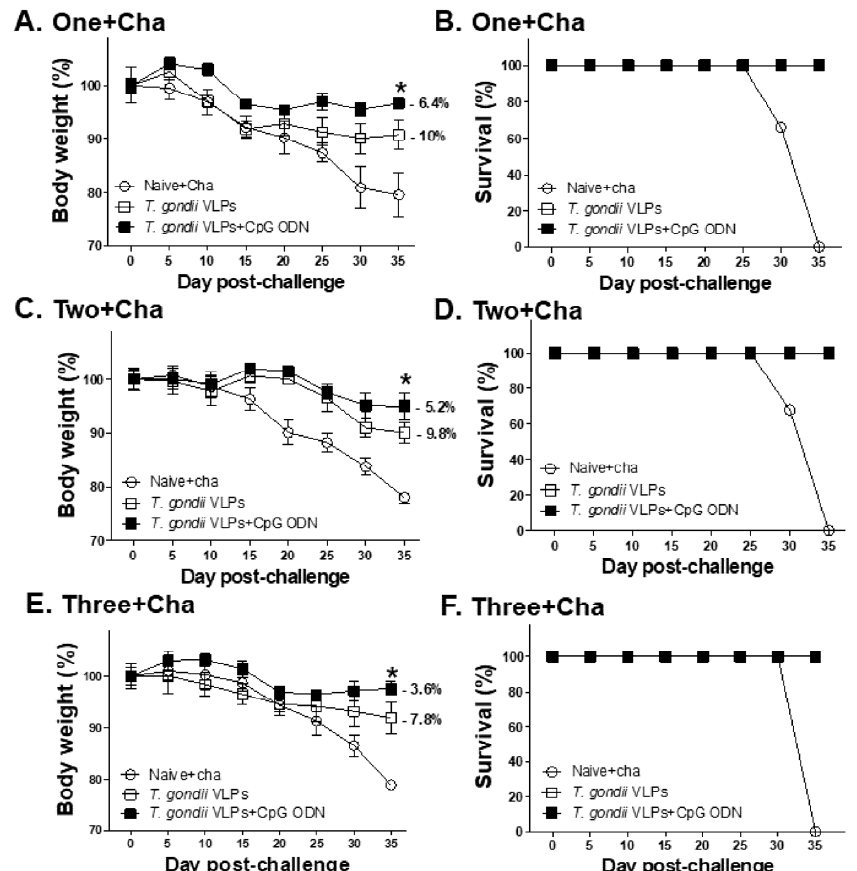
Figure 8. Protective e ffi cacy induced by T. gondii VLPs alone and adjuvanted T. gondii VLPs following multiple immunizations. Immunized mice ( n = 6 per group) were challenge-infected after the final immunization and monitored for 35 days. Bodyweight reductions ( A , C , E ) and survival rates ( B , D , F ) from mice immunized once, twice, or thrice were measured during this period. Results are presented as mean ± SD and statistical significances were denoted using asterisks (* p < 0.05).